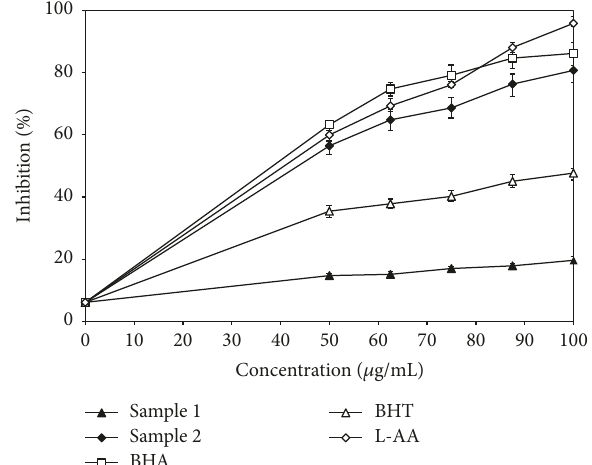
Figure 1: Free radical-scavenging activity of extracts from C. multiflorus sarcocarp measured by DPPH assay. Sample 1: the sample extracted by ethanol-water (7: 3, v/v); Sample 2: the sample reextracted from Sample 1 by ethyl